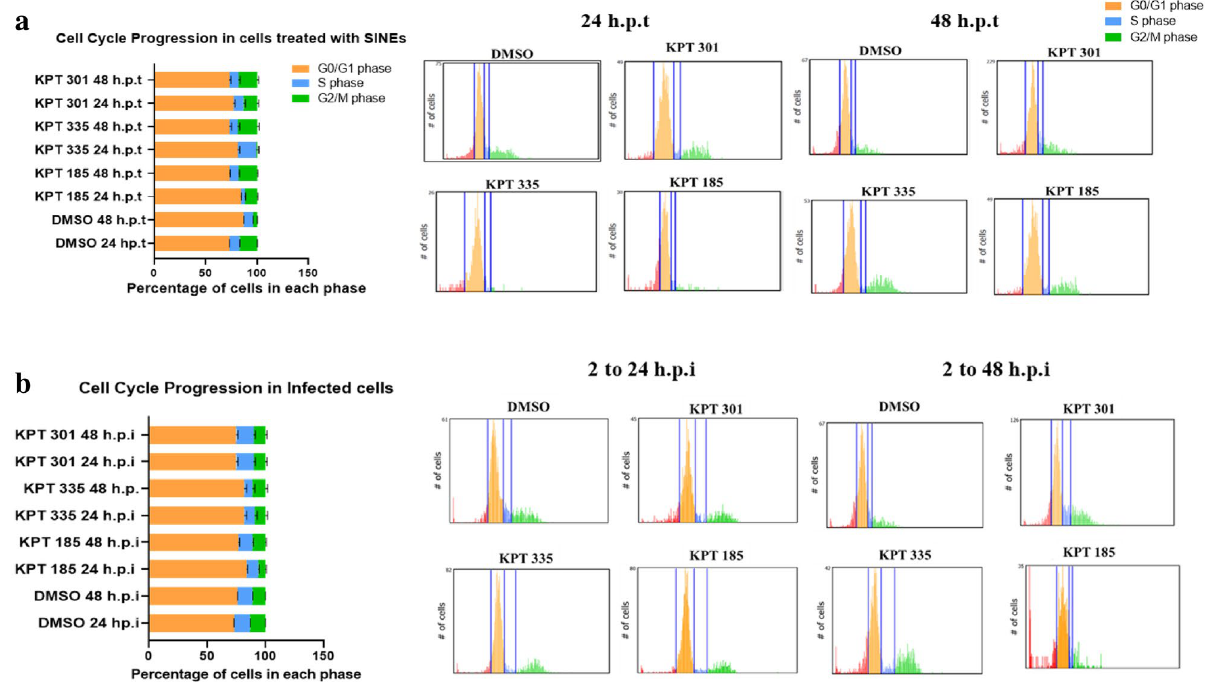
Figure 7. SINE compounds delay cell cycle progression. Sub-confluent monolayer of A549 cells were incubated for 24 h in Serum Free DMEM to allow synchronization of cell cycles to G0/G1 phase. ( a ) Non-infected cells were incubated for 24 h or 48 h in infection medium containing DMSO, 1.5 µM KPT-185 or 1.5 µM KPT-335. ( b ) Cells were infected with RSV-A2 (MOI = 1) for 1 h, further incubated for 2 h without the virus and treated with SINE compounds or DMSO for 24 or 48 h. The cells were trypsinized and fixed in 80% ice-cold ethanol. Tali™ Cell Cycle Kit and Tali ® Image-Based Cytometer were used to determine the percent of cells in each phase of the cell cycle. Bar charts on the left depict distribution of cells in each cell cycle phase; data shown are mean ± SEM. Each sample was tested in duplicate and data shown are from two independent experiments. The percentage of cells distributed in each phase of the cell cycle was plotted using GraphPad Prism v.8.4.3. Representative histograms for SINE- or DMSO-treated cells are shown on the right. The red region indicates cells in the G0 phase, yellow G1 phase, blue S phase and green G2/M